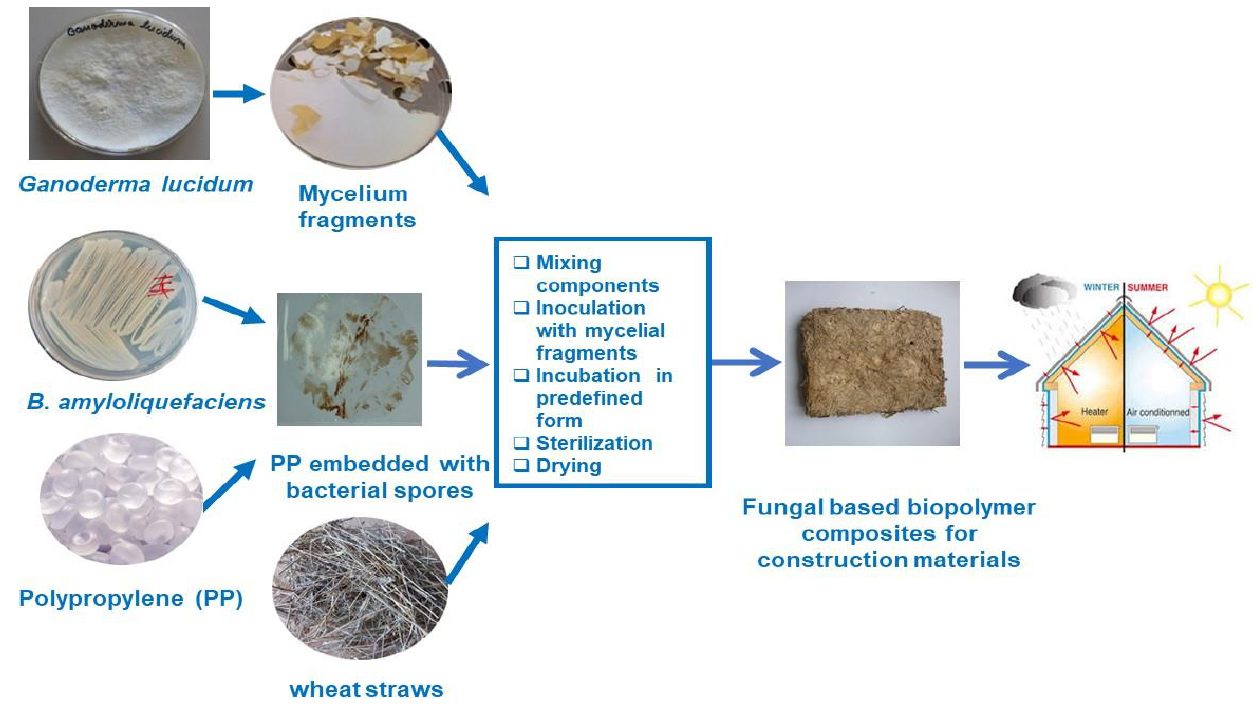
Figure 4. Schematic representation for preparation of fungal composite material.